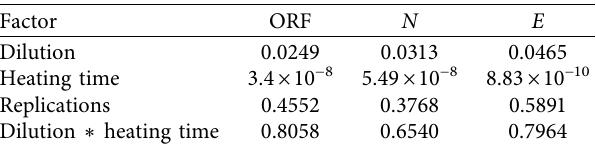
Figure 2: Δ Ct values in relation to the control reaction and influencing factors: genes ORF1ab, N, and E, three dilutions (1:1, 1 :10, and 1: 100), and four heating times (5, 10, 15, and 20 min). Blue points are minimum and maximum differences to control, red points are mean values, and green lines are the joining mean values to improve interpretation. Table 1: p values relative to dilution, heating time, replications, and interaction of dilution and heating time of two-way ANOVAs for genes ORF1ab, N, and E